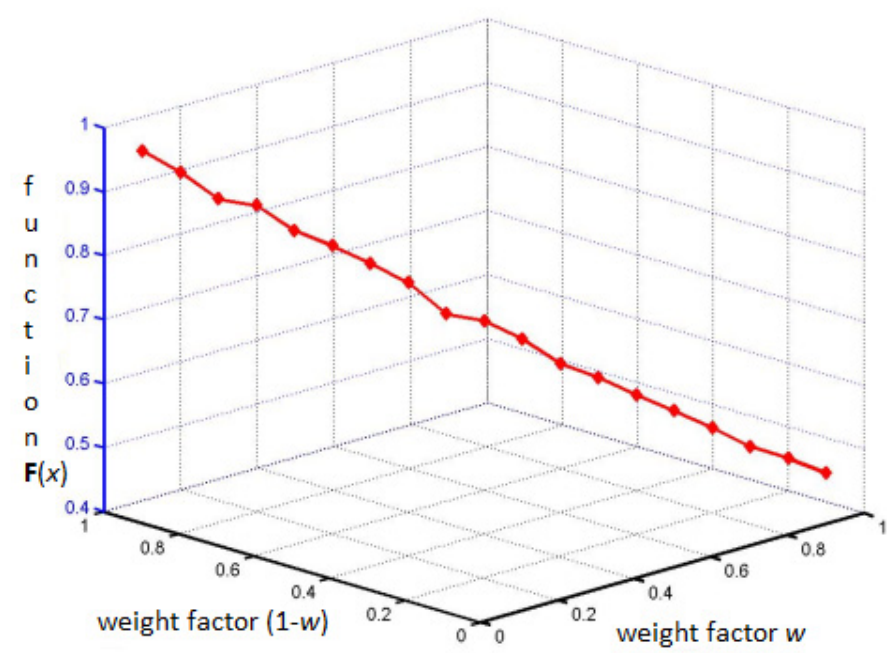
Figure 5. Graph presenting the values obtained for function (1) depending on the weight factors.